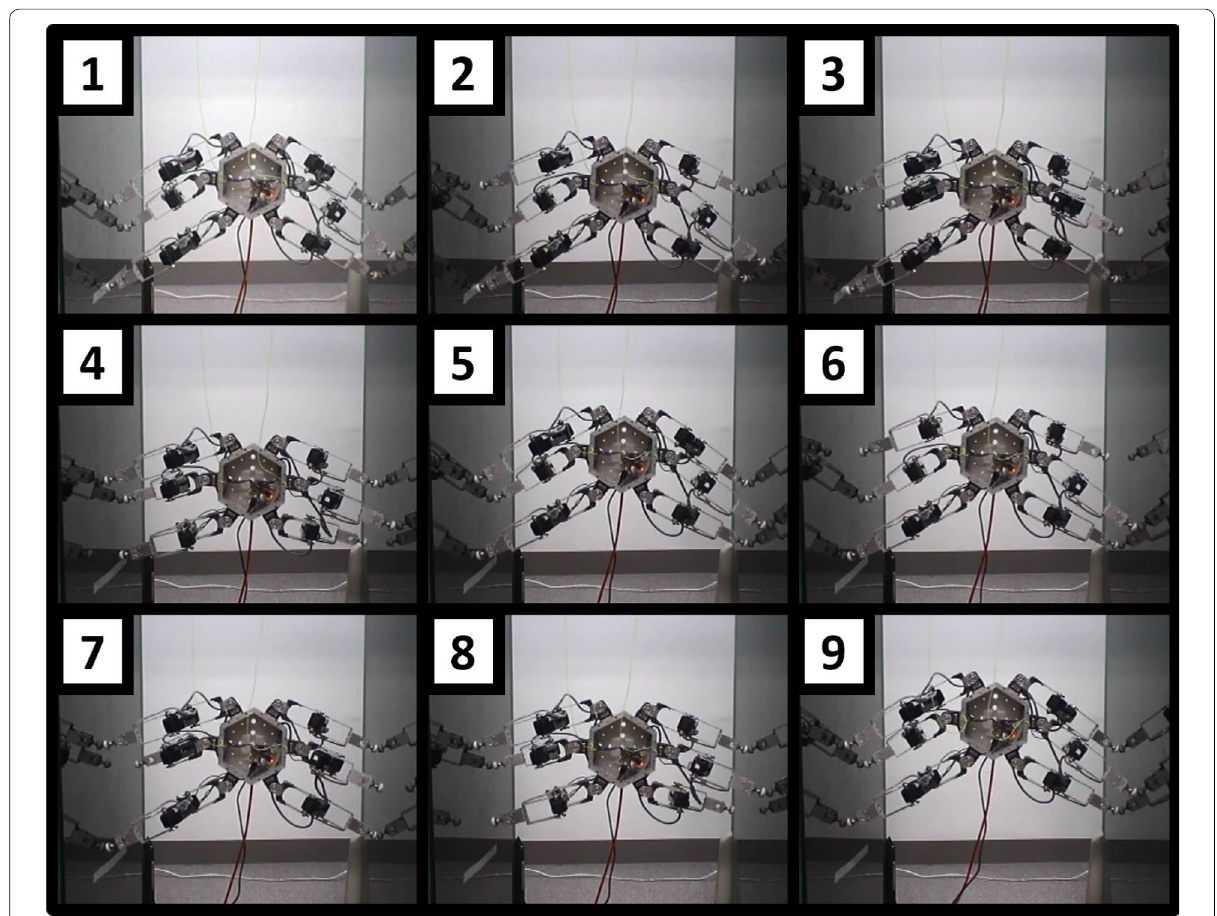
Fig. 13 Experimental scene of vertical-body climbing gait considering power efficiency